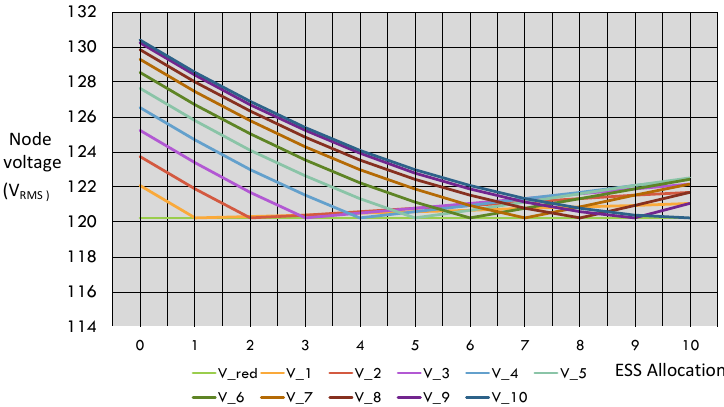
Figure 4. Node voltage (V RMS ) vs. node ESS Allocation.